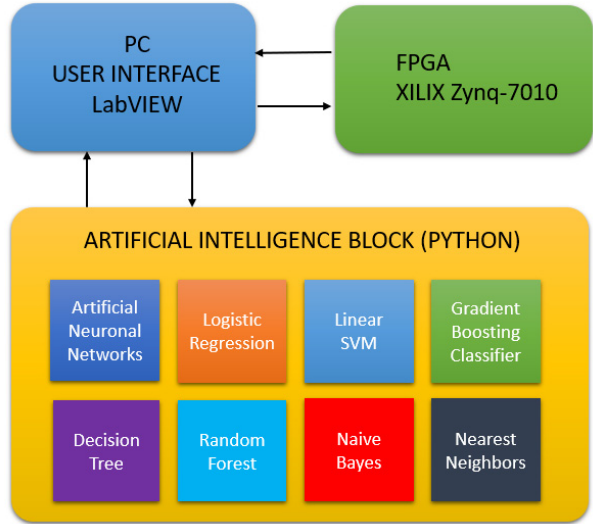
Figure 3. Integration of the personal computer (PC) graphical user interface (GUI) with the FPGA and the artificial intelligence block.